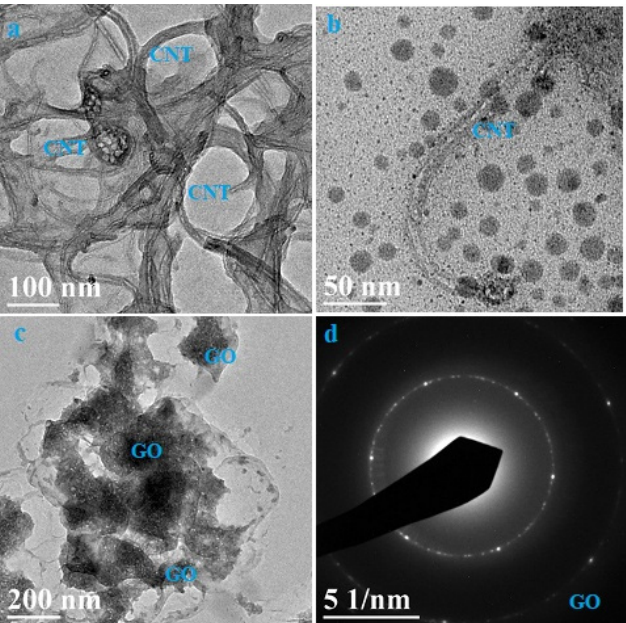
Figure 4. TEM ( a , b ) for FCNT@isocyanate 50 wt.% ( c ) for GO@isocyanate 50 wt.% and ( d ) image is selected area electron diffraction (SAED) pattern acquired for the 50 wt.% graphene- oxide@iscocyanate composite.